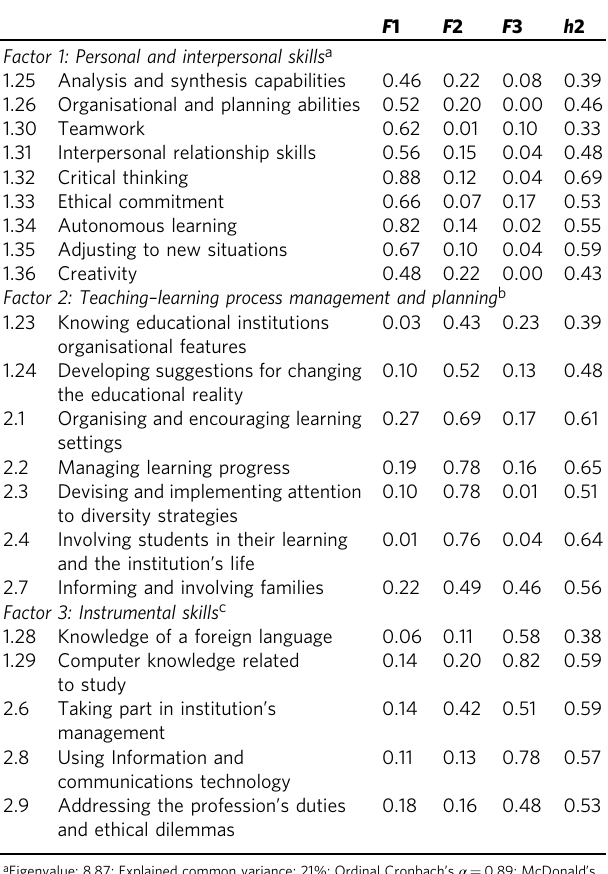
Table 1 Exploratory factor analysis. saturations, communalities and explained